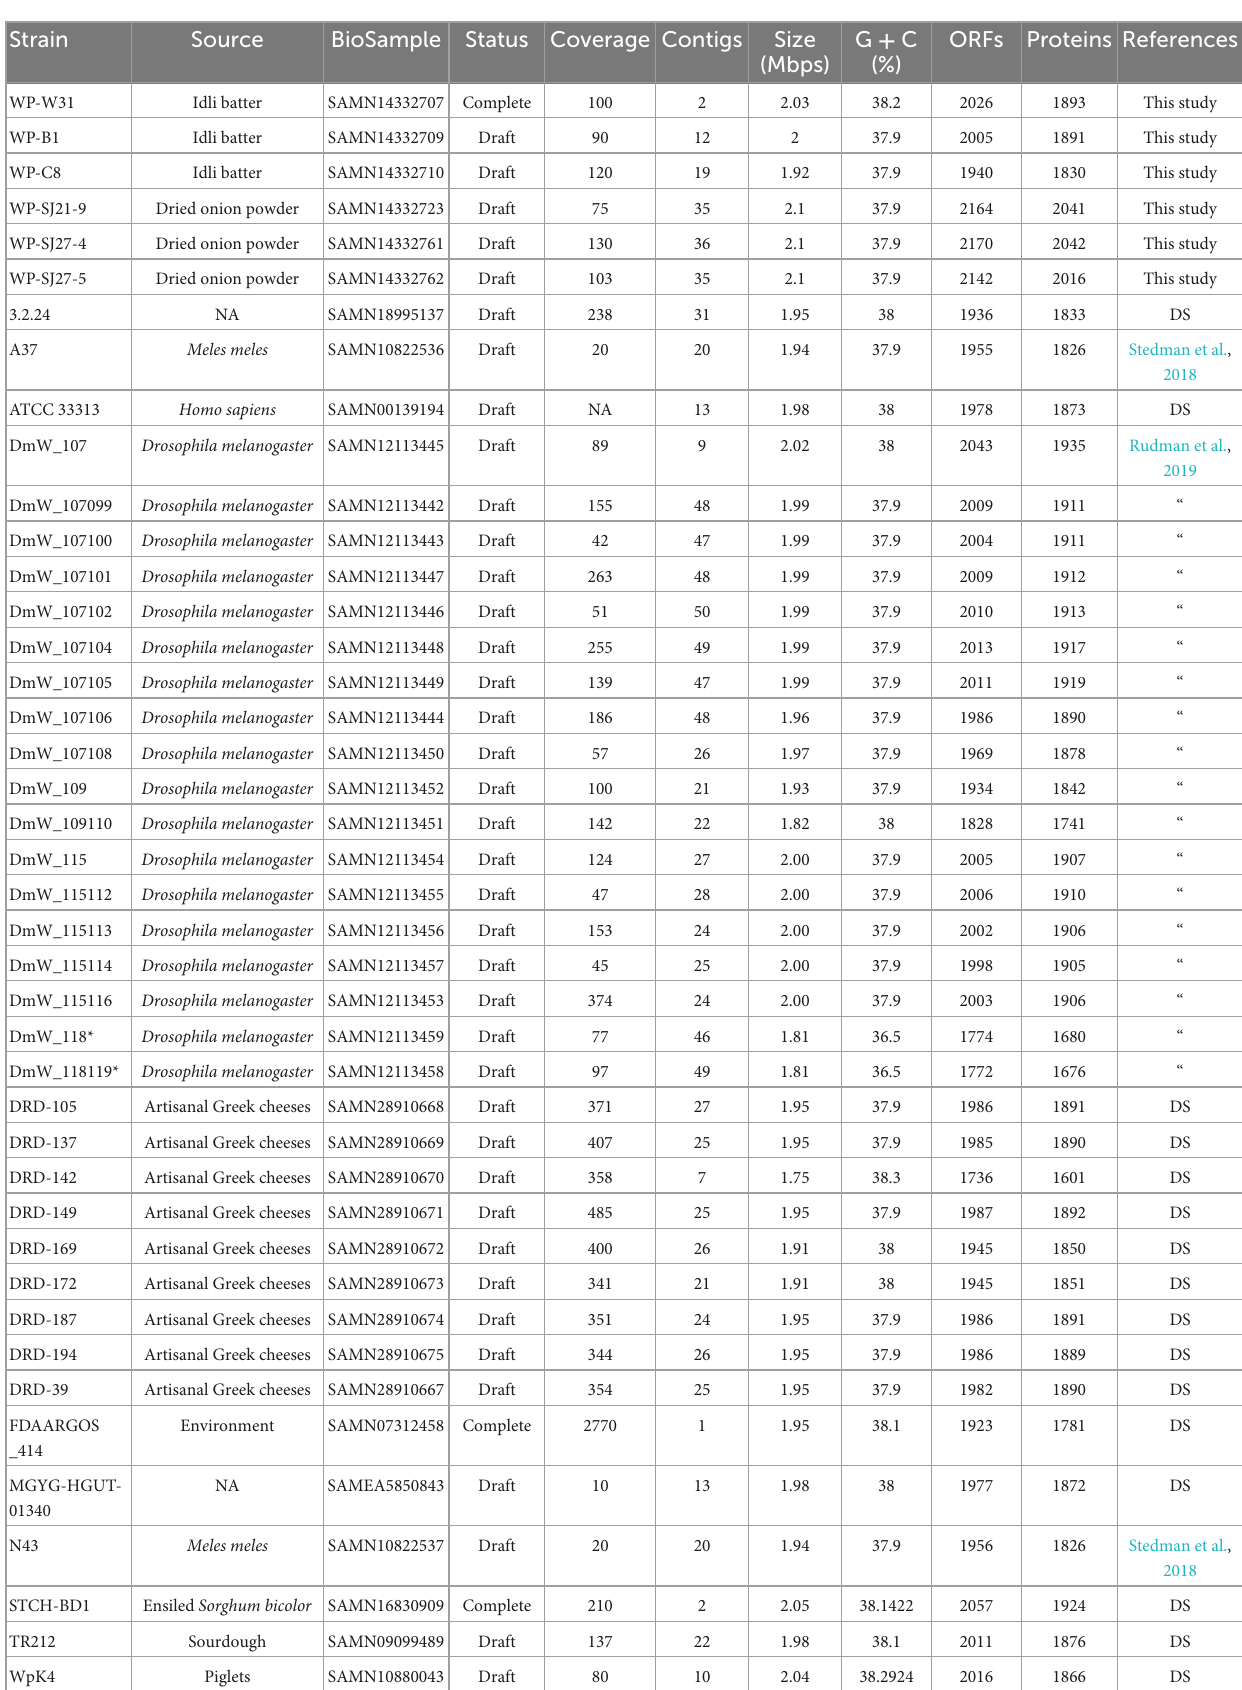
TABLE 1 A general overview of 42 Weissella paramesenteroides